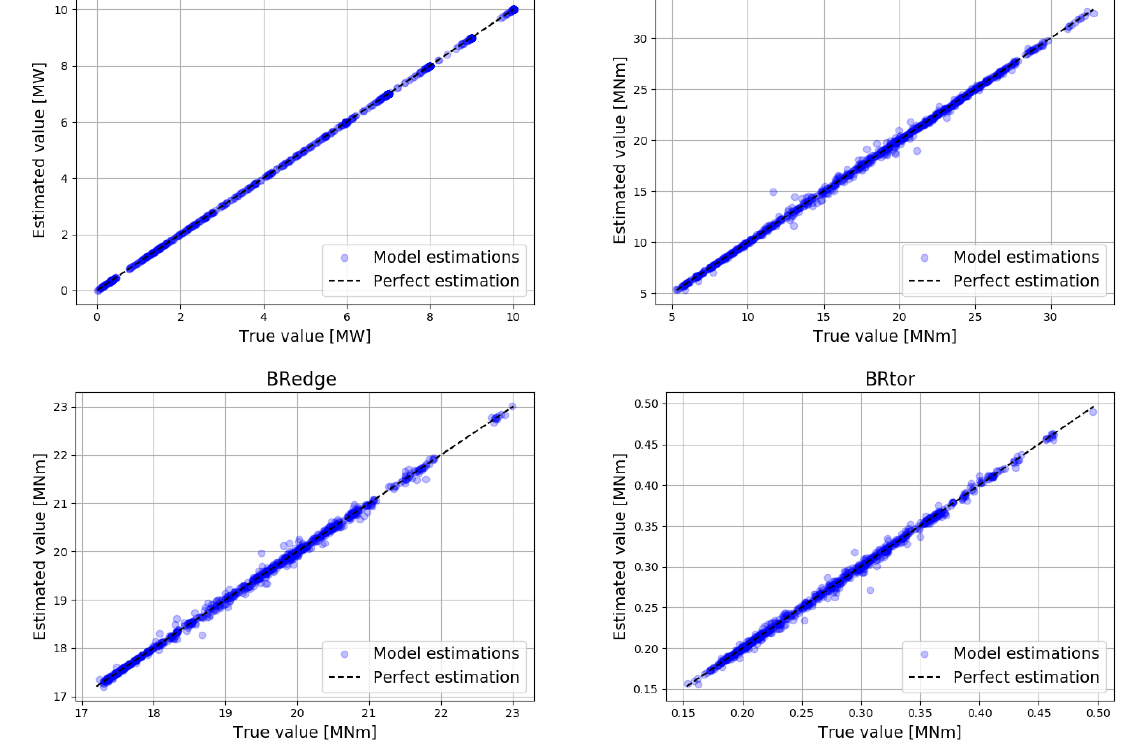
Figure 4. Electrical power, BRflap, BRedge and BRtor estimated and observed values for GPR